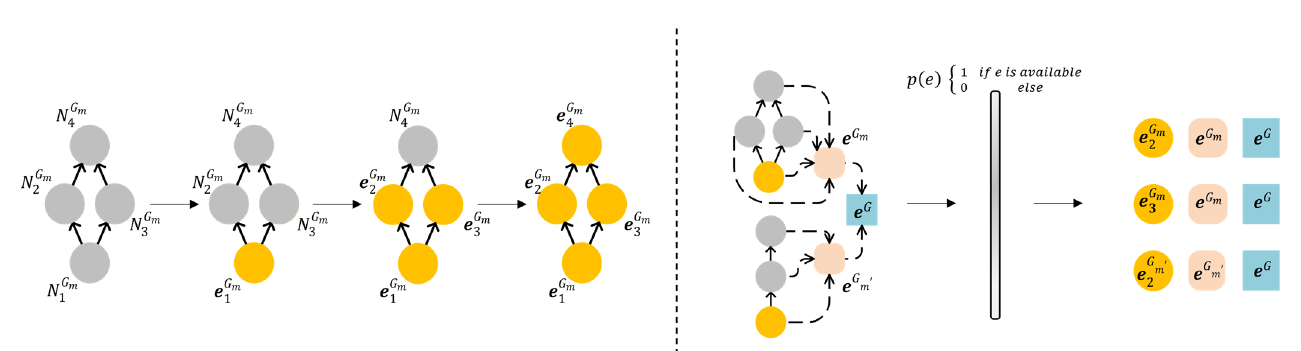
Figure 3. Extracting DAG